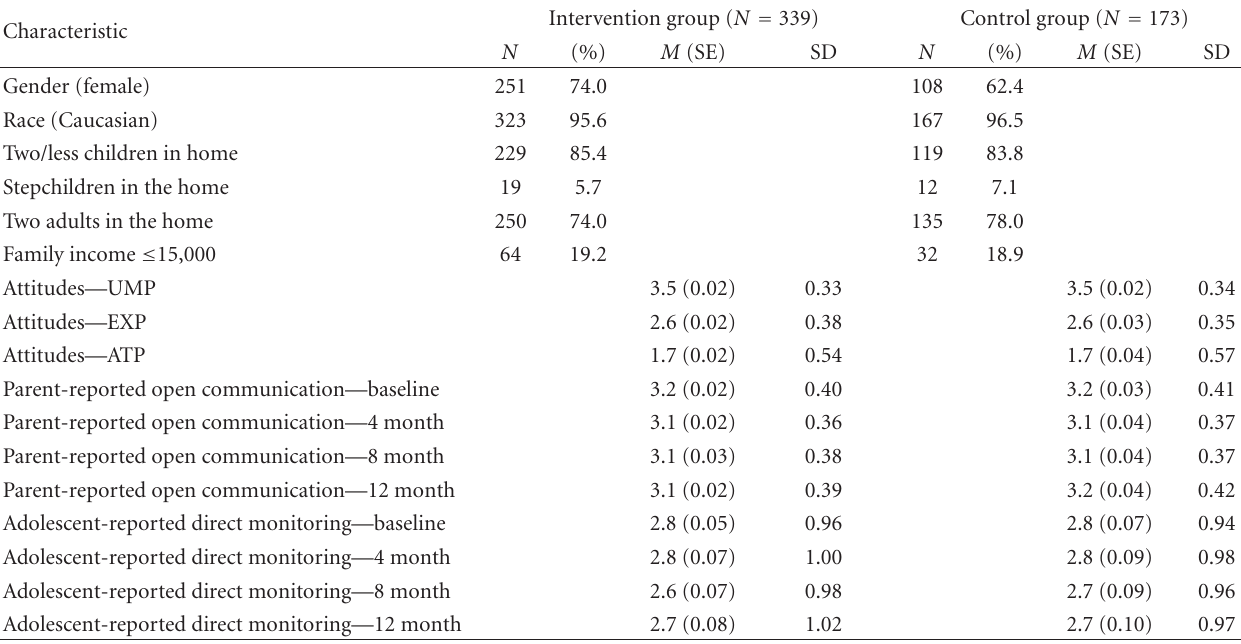
Table 1: Study sample characteristics valid percentages, and mean reporting.